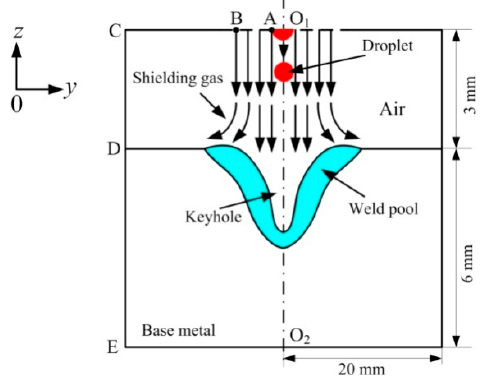
Figure 3. Schematic sketch of the calculation domain.